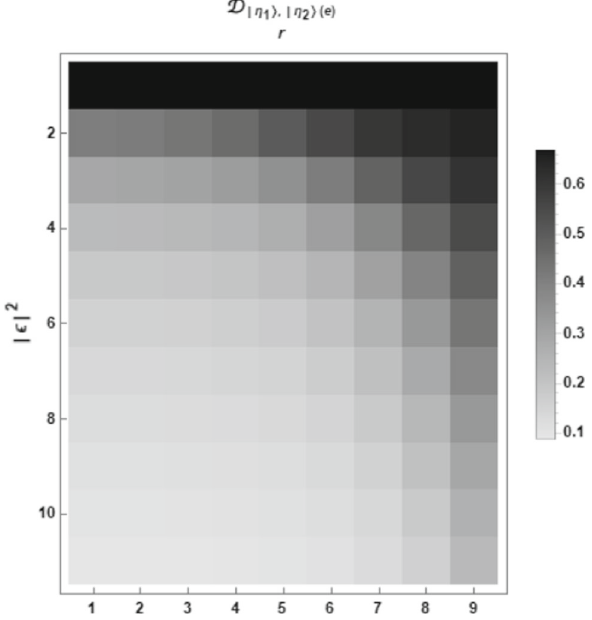
Fig. 12 Array Plot for the Table 8 showing numerical values of D coherent and squeezing parameters